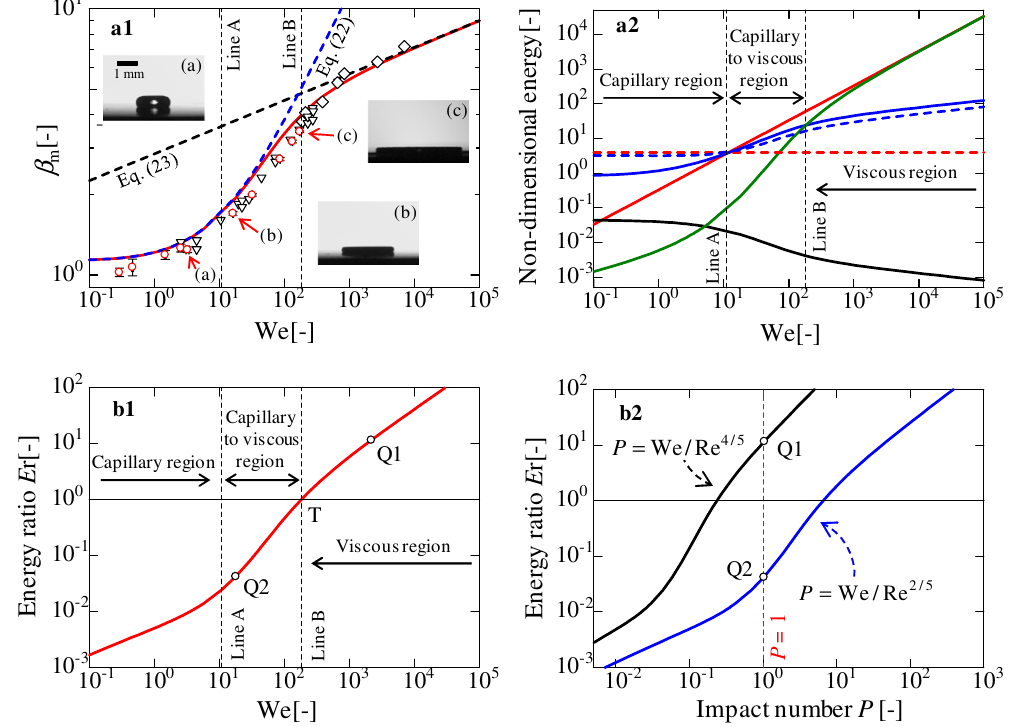
Figure 4. Energy transition from capillary to viscous regimes of a water droplet on SR. (a1) Plot of β m versus We. Red circles ( ⚪ ) represent the experimental data obtained in this study. White diamonds ( ⬦ ) and inverted triangles ( ▿ ) represent water on an Al substrate and a superhydrophobic surface, respectively 17 . (a2) Plot of non- dimensional energy versus We. The solid red, black, blue, and green lines represent kinetic energy ⁎ E = We/3), gravitational potential ( ⁎ E = 2 ρ = (1 − cos θ ) σ ( ⁎ E l gr 0 h m /(3 lg )), adhesion energy ( kine grav sprd m2 Re)). The dashed red and blue lines = 27 r 02 β θ ), and viscous dissipation ( ⁎ E β m2 − ( β m h m / r 0 )sin m We/(16 h vis = 4) and surface energy deformed surface ( ⁎ E = S π r 02 )). (b1) Plot of E represent initial surface energy ( ⁎ E def /( r surf def versus We. (b2) Plots of E r versus impact numbers P = We/Re 4/5 and We/Re 2/5